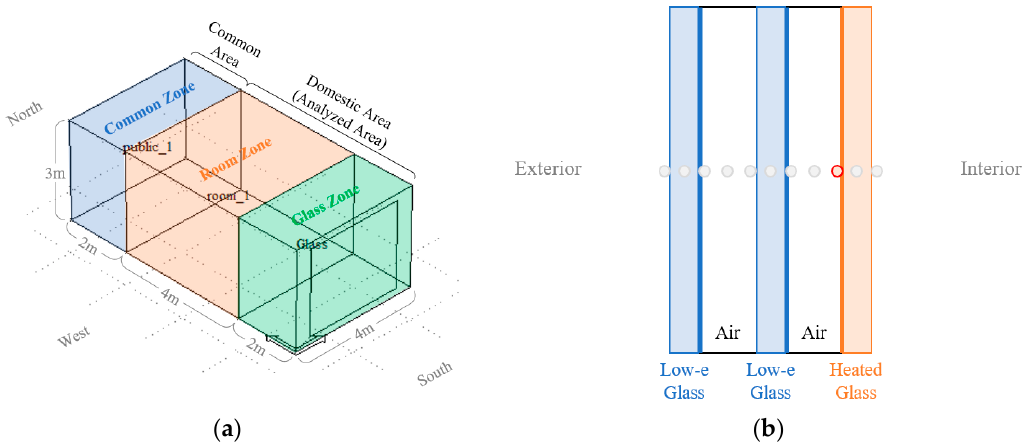
Figure 2. Illustration of the model and heated glazing in the simulation program. ( a ) The building model in the simulation program; ( b ) The section layout of heated glazing.